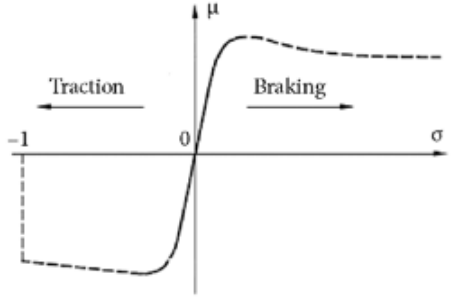
Fig. 3. Dependency of μ on sliding in traction and braking